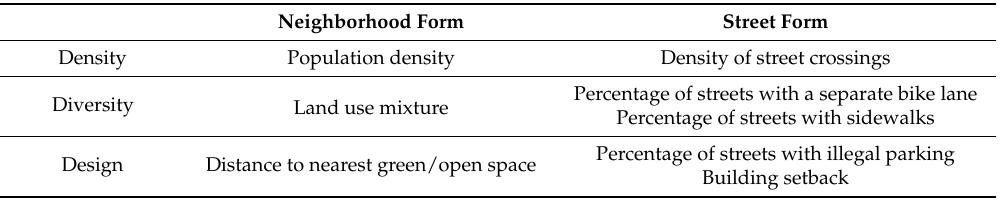
Table 1. Indicators for the built